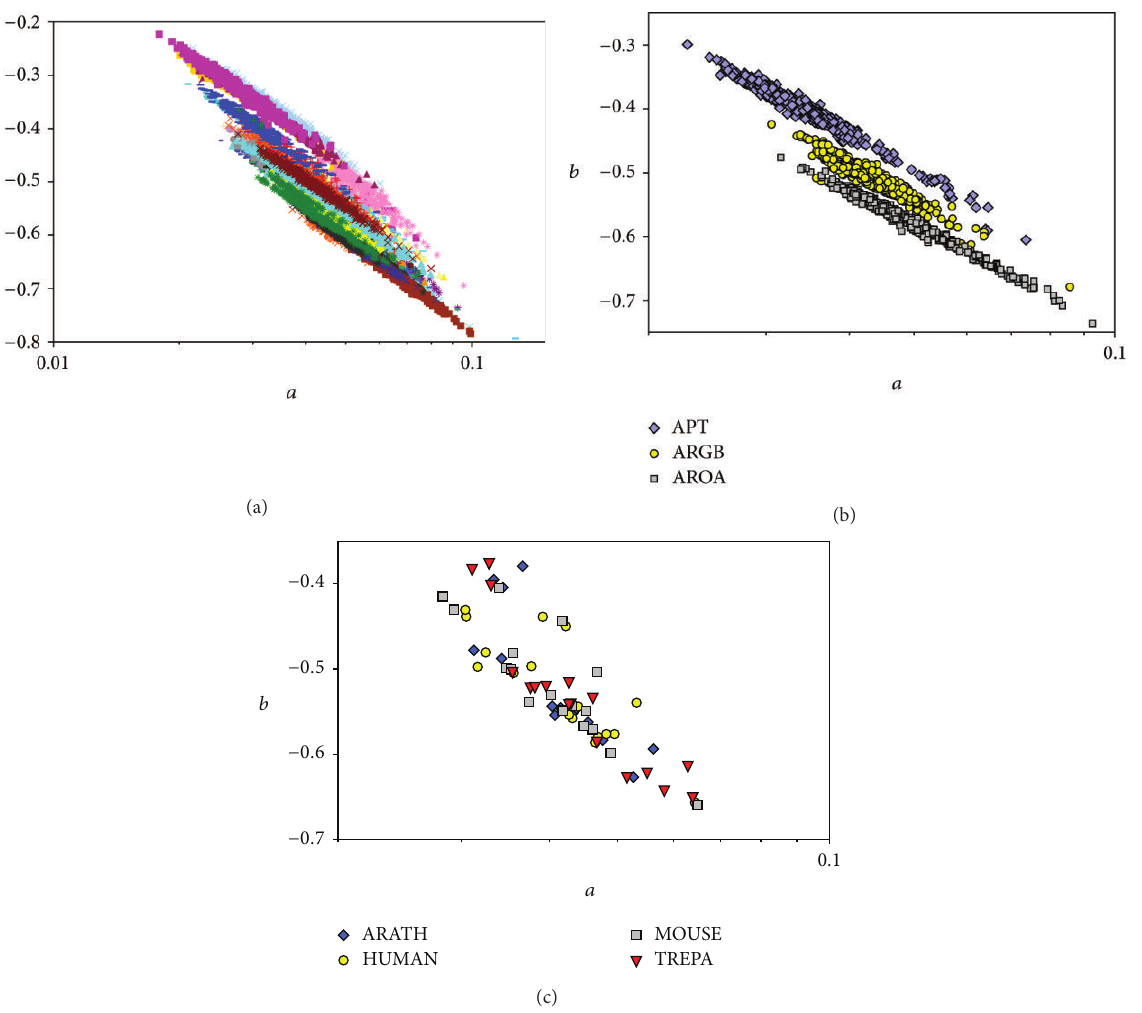
Figure 7: (a) PL regression locus (𝑎, 𝑏) of 27204 2-tuple HSRFs in Dataset 1. (b) PL regression locus (𝑎, 𝑏) of genes APT, ARGB and AROA (1803 2-tuple HSRFs) in Dataset 1. (c) PL regression locus (𝑎, 𝑏) of organisms ARATH, HUMAN, MOUSE, and TREPA (66 2-tuple HSRFs) in Dataset